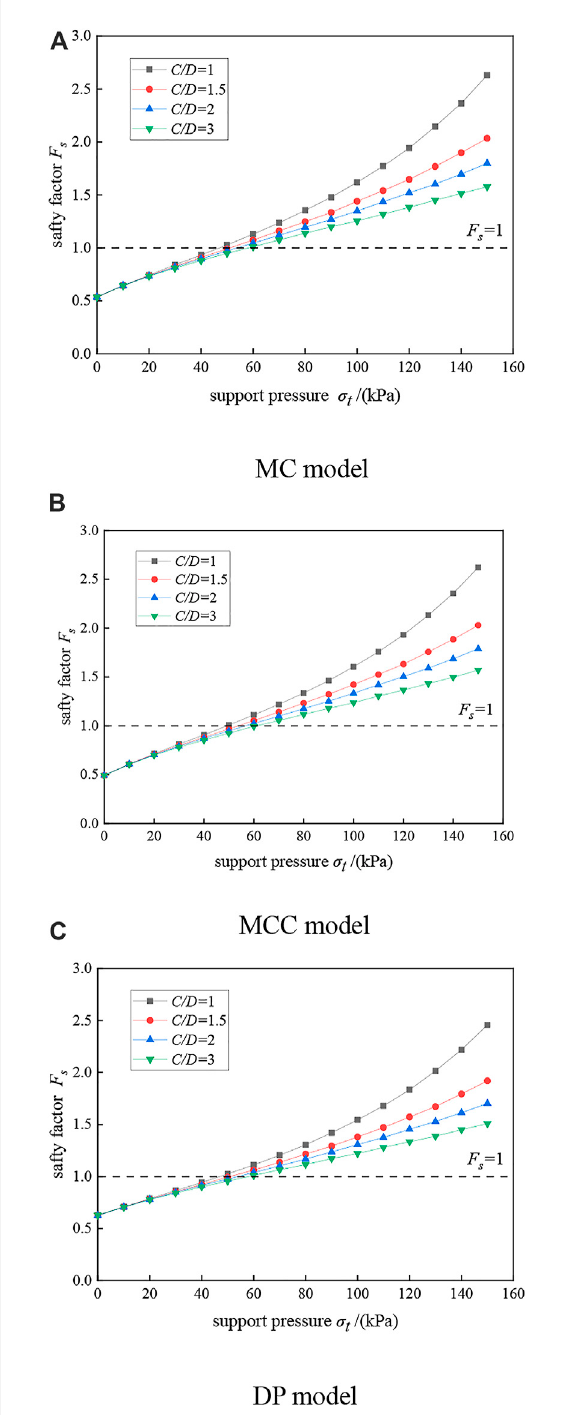
Variation of safety factor with support pressure under different C/D. (A) MC model, (B) MCC model, (C) DP